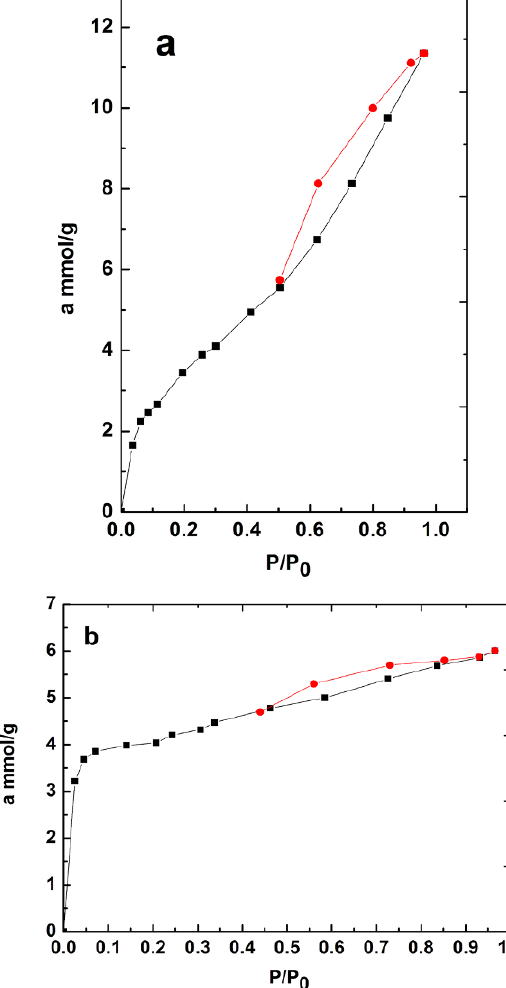
Figure 3. Nitrogen adsorption isotherm of TiO (a) 680 o C; 830 o C